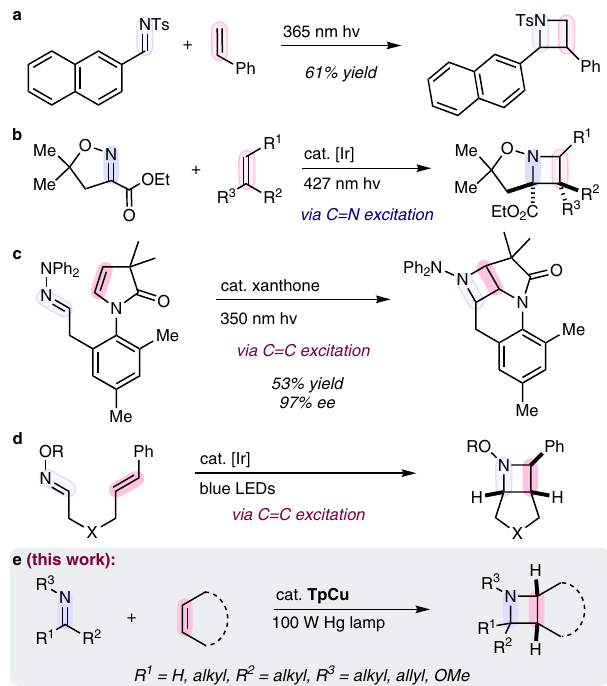
Fig. 1 Previous strategies of azetidine forming 2 + 2 photocycloadditions and this approach. a Use of substrate π -stacking pre-organization 13 . b Activation via cyclic glyoxylate imine sensitization 16 . c Xanthone sensitization 17 . d Activation via Ir-mediated sensitization 18 . e Alkene activation via Cu-coordination and excitation. Tp = hydrotris(pyrazolyl)